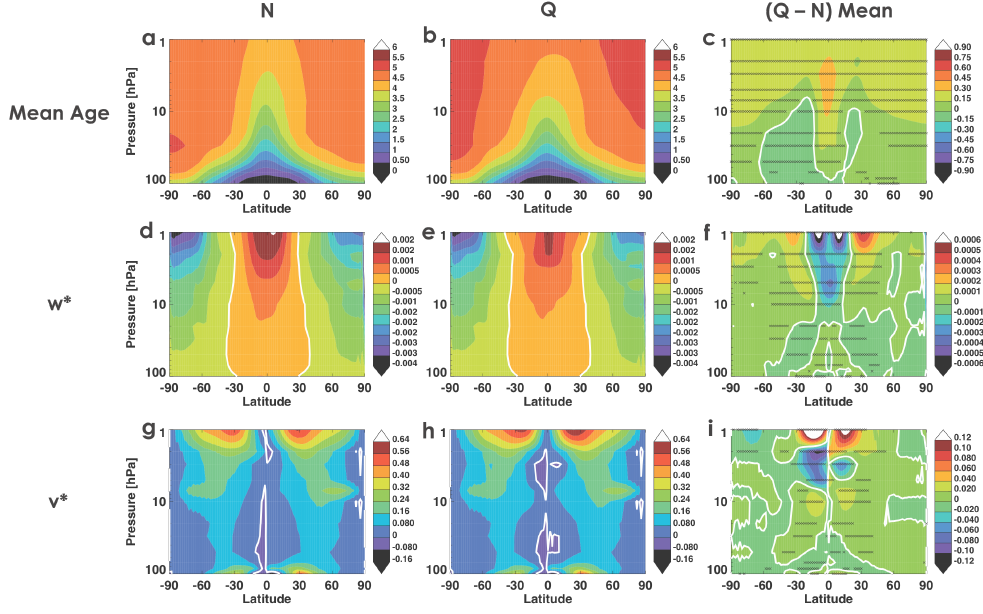
Figure 5 : As for Figure 3, but for (a–c) mean age [years], (d–f) w* [m s -1 ] and (g–i) v* 523 Fig. 5. As for Fig. 3, but for (a–c) mean age (years), (d–f) w ∗ (ms − 1 ) and (g–i) v ∗ (ms − 1 ). Note that values of v ∗ in the Southern Hemisphere are multiplied by − 1, such that positive v ∗ values indicate poleward motion in both hemispheres. [m s -1 ]. Note that values of v* in the Southern Hemisphere are multiplied by –1, such 524 that positive v* values indicate poleward motion in both hemispheres. 525 526